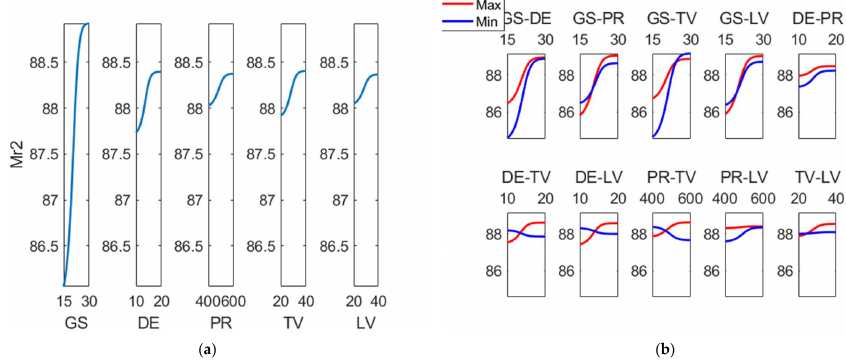
Figure 13. ( a ) Main effects plot and ( b ) interaction effects plot for (Mr2 (%)). Figure 14 corresponds to the main effects plot and the interactions effect plot for (Rz). As with (Rk), the main factors are GS and PR, and the main interactions are those related to GS.